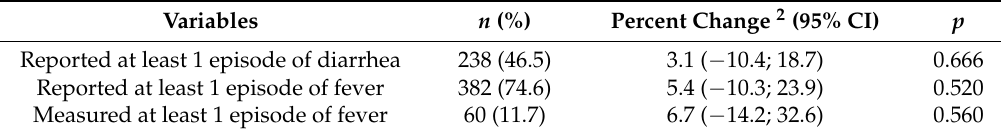
Table 4. Associations between endline HCC and morbidity in the previous 3 months 1